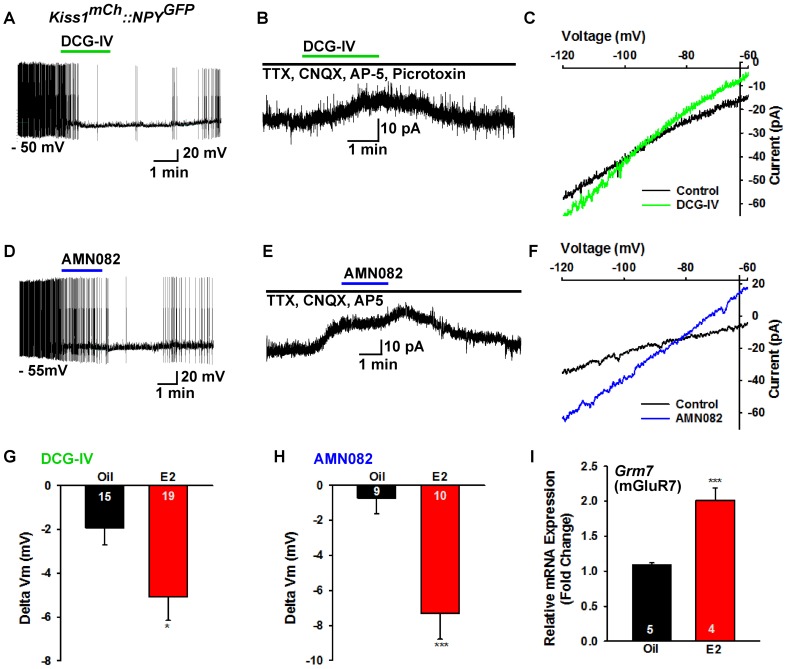
Metabotropic glutamate response is inhibitory in NPY neurons and augmented by E2.(A) the group II mGluR agonist DCG-IV (10 µM) hyperpolarized a NPYGFP neuron. (B) DCG-IV activated an outward current in a NPYGFP neuron in the presence of fast sodium channel (TTX, 0.5 μM), ionotropic glutamatergic (CNQX, 10 μM and AP5, 50 μM) and GABAergic (picrotoxin, 100 μM) blockers (V hold = −60 mV). (C) I-V relationship for DCG-IV- induced current showed a reversal at EK+ (−95 mV). (G) DCG-IV was more efficacious to hyperpolarize NPY neurons in E2-treated versus oil-treated, OVX females (Unpaired t-test, t(32) = 2.261, p=0.031). *p<0.05. (D) the mGluR7 allosteric agonist AMN082 (10 µM) hyperpolarized and inhibited firing of an NPYGFP neuron. (E) AMN082 generated a 25 pA outward current in a NPYGFP neuron in the presence of fast sodium channel and ionotropic glutamatergic blockade (V hold = −60 mV). (F) I-V relationship for AMN082-induced current showed a reversal close to EK+. (H) AMN082 was more efficacious than DCG-IV to hyperpolarize NPY neurons in E2-treated versus oil-treated, OVX females (Unpaired t-test, t(17) = 3.747, p=0.002). (I) Quantitative real-time PCR measurements of Grm7 mRNA in NPYGFP neuronal pools (4 pools of 5 cells each per animal) from oil- and E2-treated, OVX mice (n = 4–5 animals per group). Bar graphs represent the mean ± SEM (Unpaired t-test, t(7)=6.020, p=0.0005). ***p<0.001.10.7554/eLife.35656.020Figure 10—source data 1.DCG-IV was more efficacious to hyperpolarize NPY neurons in E2-treated versus oil-treated, OVX females (Figure 10G).AMN082 was more efficacious than DCG-IV to hyperpolarize NPY neurons in E2-treated versus oil-treated (Figure 10H). Grm7 mRNA expression in NPY neurons (Figure 10I).